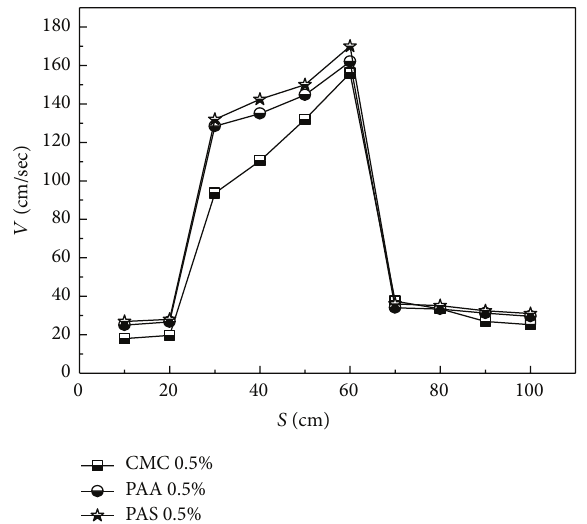
Figure 9: Position of bubble front corresponds to the velocity of bubble for 0.5 wt% viscoelastic fluids ( 𝑄 = 600 mL/min and 𝜃 = 45 ∘ ).